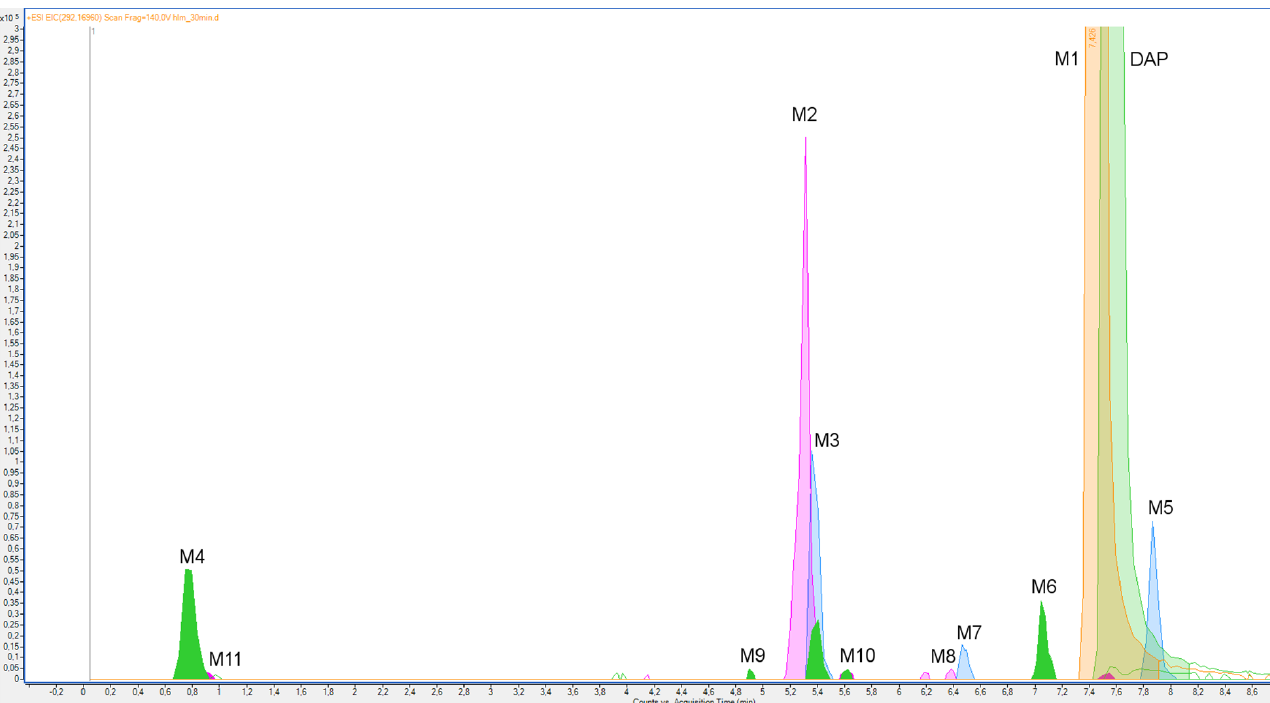
Figure 1. Overlapped extracted ion chromatograms (EIC) of dapoxetine (DAP) and its metabolites (M1–M11) after a 30-min incubation with